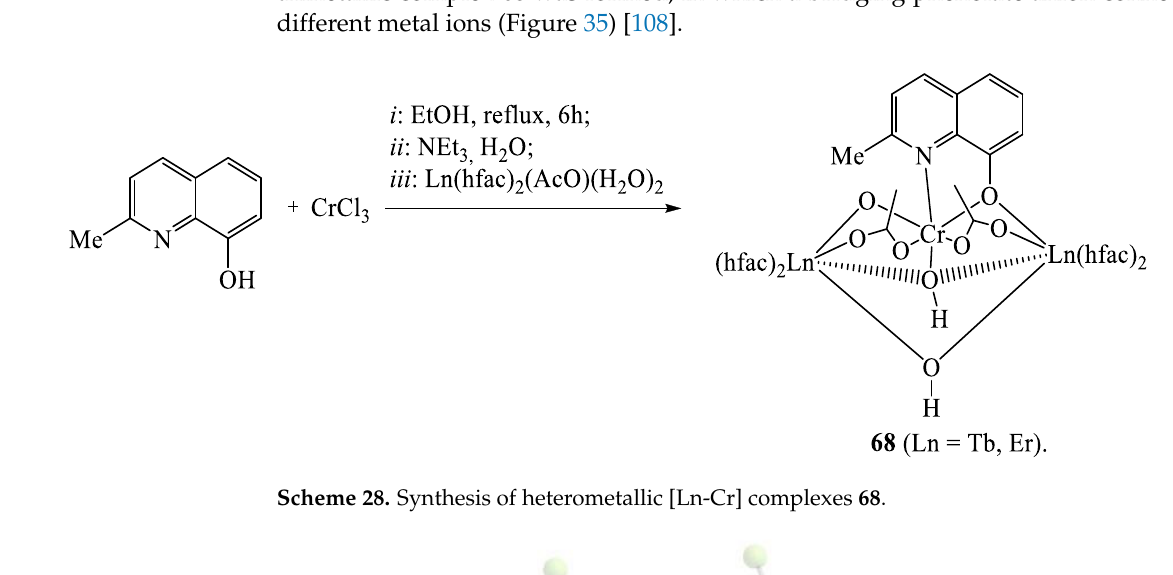
Figure 34. Molecular structure of 67 [105]. The cif has been retrieved from CCDC. CCDC number is 1961116.